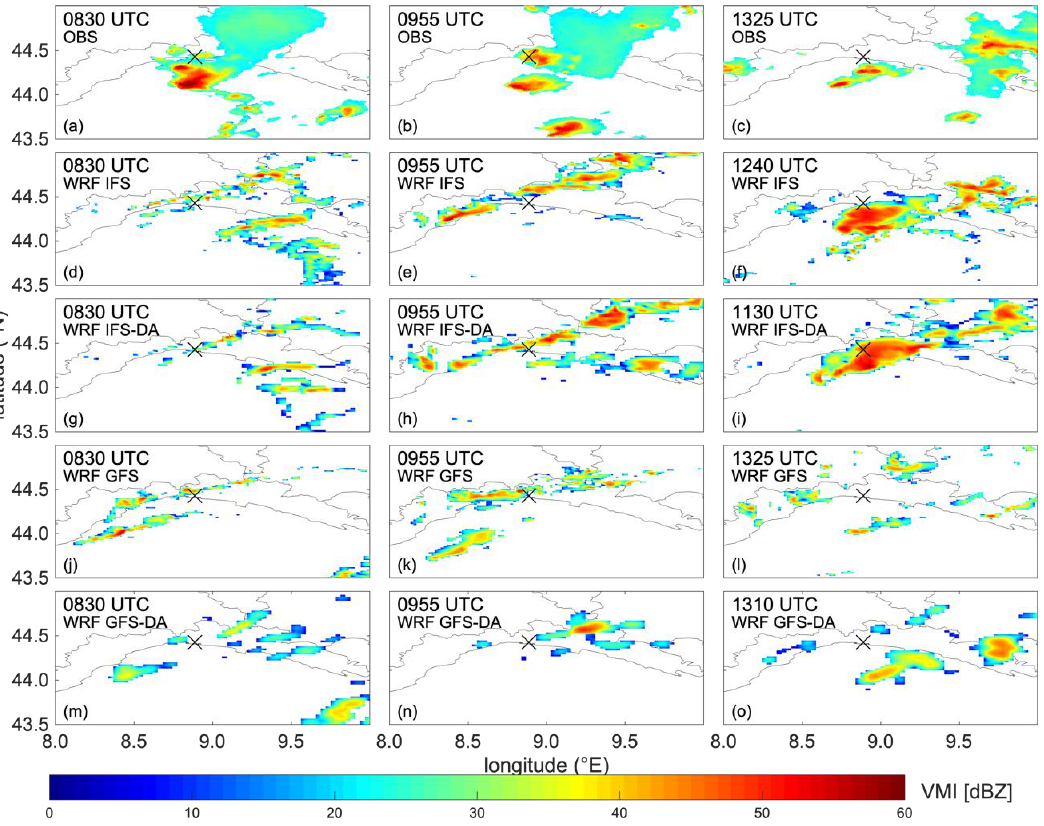
Figure 18. Radar reflectivity (dBZ) measured by the Ligurian Doppler radar. Vertical Maximum Intensity (VMI) maps from observations ( a) –( c ) and WRF simulations ( d) –( l ). The position of Morandi bridge is indicated by the black cross.